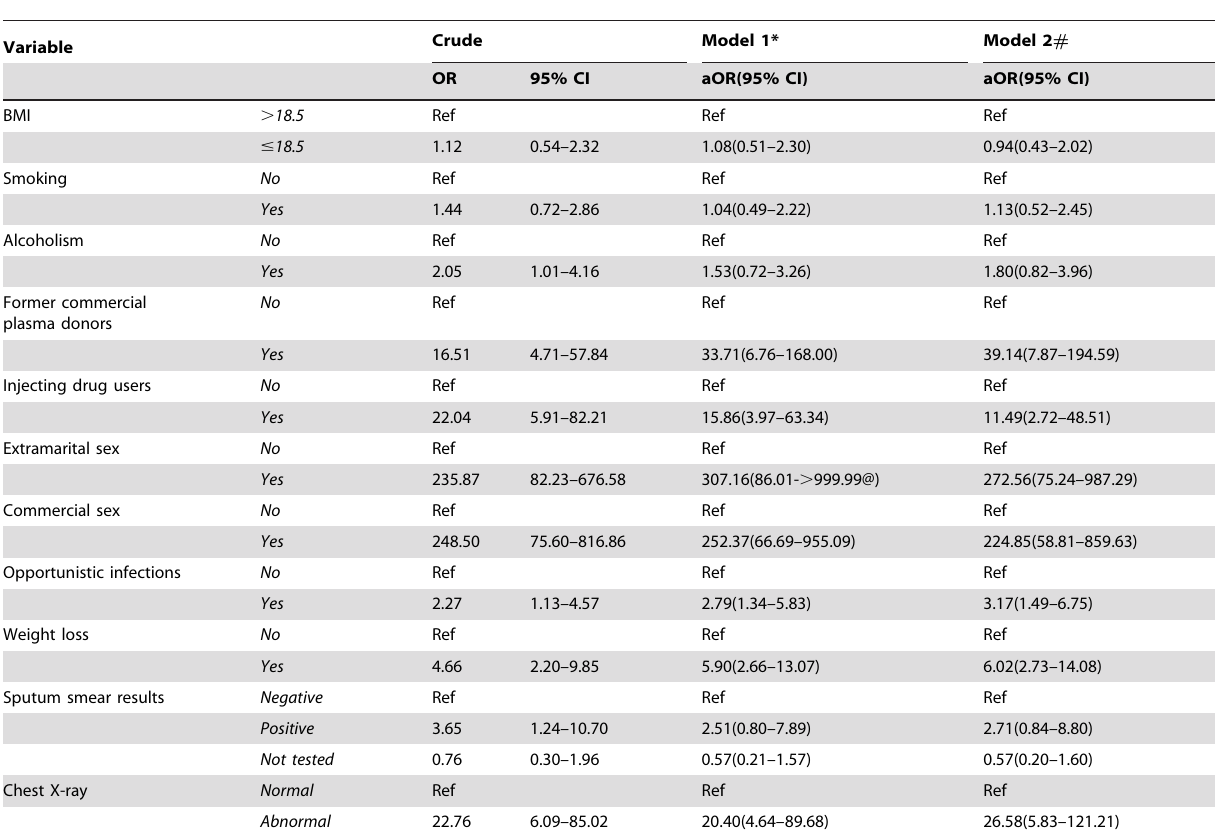
Table 2. Factors correlated with HIV infection among TB patients in three provinces of China, 2010 (N